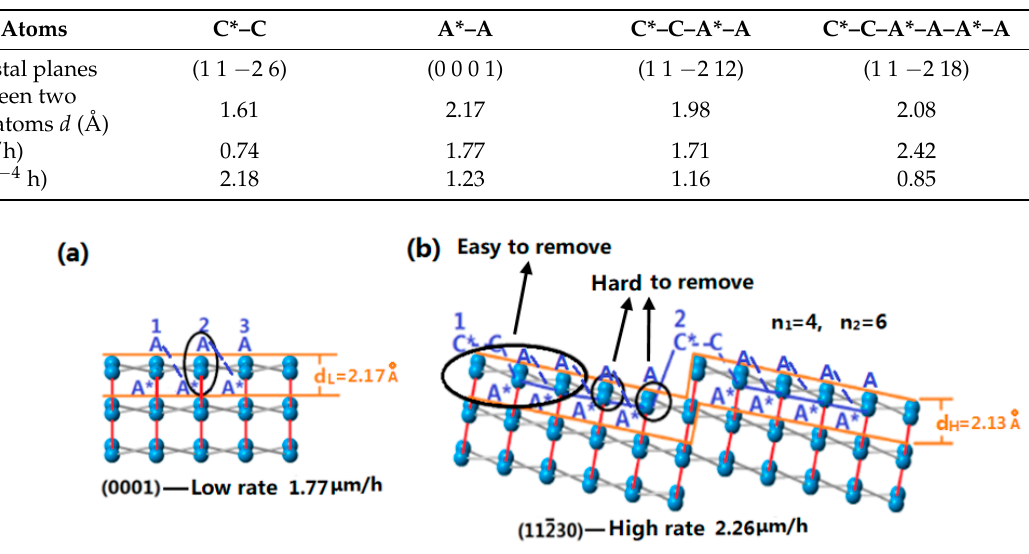
Table 4. Removal times of basic units in the concentration condition (236 °C, H 2 SO 4 :H 3 PO 4 = 3:1).